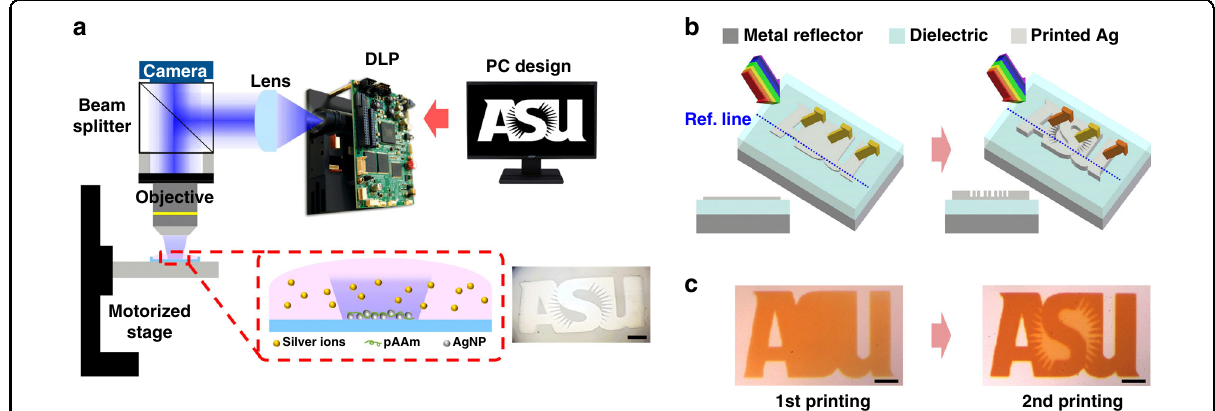
Fig. 1 Structural color printing technology. a Schematic illustration of the polymer-assisted photochemical deposition (PPD) printing setup and an example of printed ASU logo (scale bar: 500 μ m). b Three-dimensional scheme showing printing of multilayered fi lm stack into microstructures. c Optical images showing an example of printed colored ASU logo corresponding to ( b ). Scale bar: 100 μ